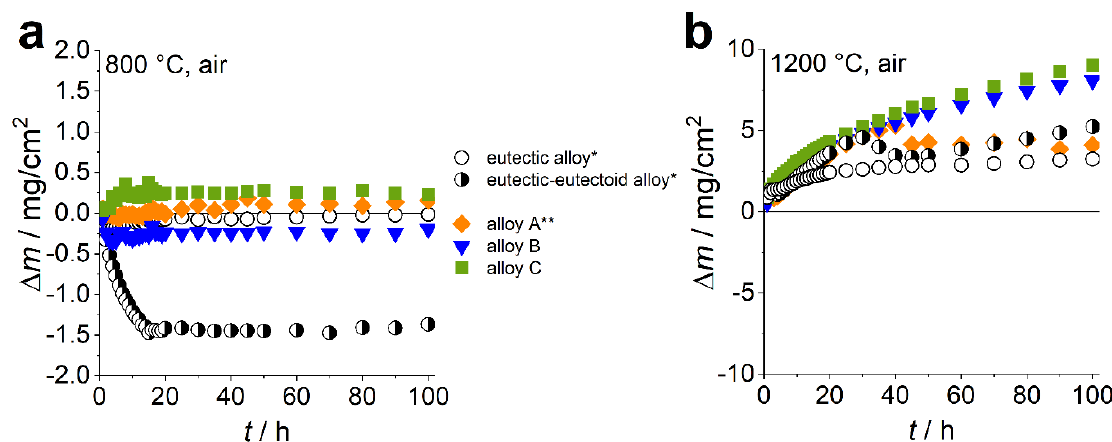
Figure 4. Specific mass change of alloys A to C during cyclic oxidation in laboratory air at 800 ( a ) and 1200 °C ( b ). *data of the eutectic and eutectic-eutectoid reference alloy are taken from [10], ** data of alloy A at 800 °C are taken from our previous article [5].